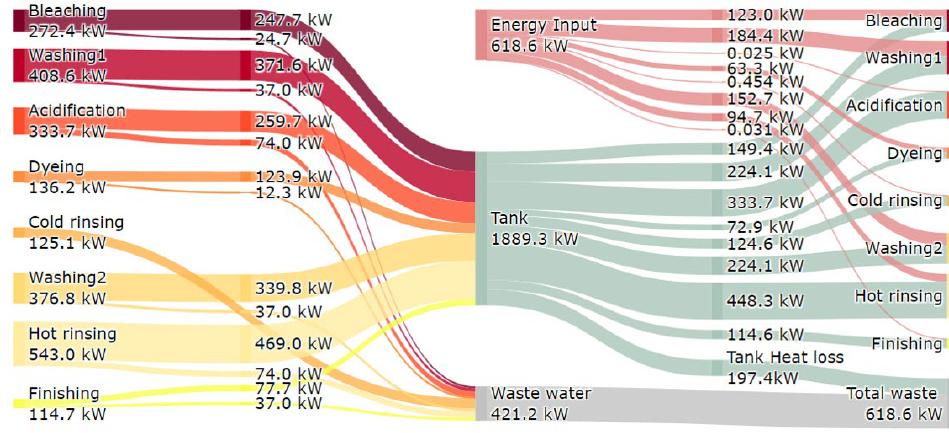
Figure 6. Energy flow for the most efficient wastewater temperature (25.1 °C) in Case 2.